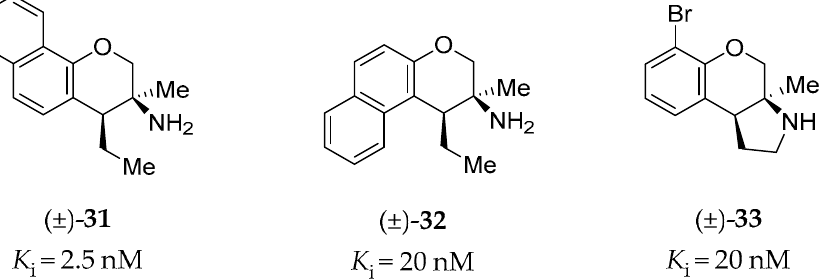
Figure 10. Representative chromane derivatives as 5-HT 2B R high-affinity ligands [146].